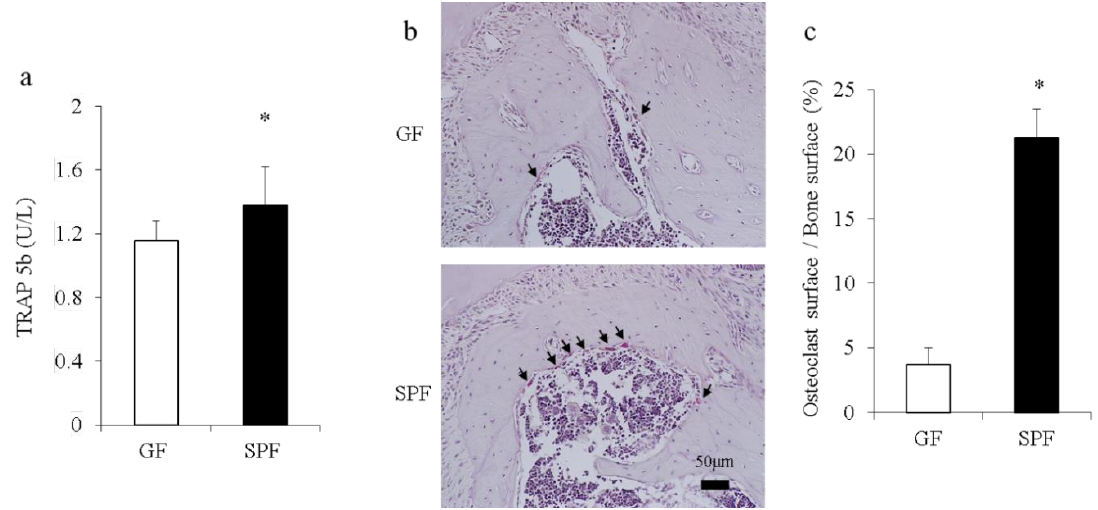
Figure 2. Serum levels of tartrate-resistant acid phosphatase (TRAP) and histomorphometric analysis of osteoclasts in GF and SPF mice. ( a ) Serum concentrations of bone markers from GF mice and SPF mice were determined by enzyme-linked immunosorbent assay (ELISA). The level of TRAP-5b was significantly higher in SPF mice than GF mice. * p < 0.05, t -test ( n = 6/group). ( b ) Representative images of TRAP-stained spongiosa. Alveolar bones from 8-week-old GF (top) and SPF (bottom) male mice were harvested, and sagittal sections were analyzed by TRAP staining. TRAP-positive osteoclasts lining bone with ≥3 nuclei designating an osteoclast (arrows). Scale bar = 50 μm. ( c ) Osteoclasts and bone surface (μm) were measured in the range of 450 μm × 400 μm based on the alveolar crest using ImageJ computer software (version 1.45, NIH, Bethesda, USA). Comparable images and data are expressed as the ratio (%) of osteoclast surface/bone surface. Data are shown as mean ± SEM.